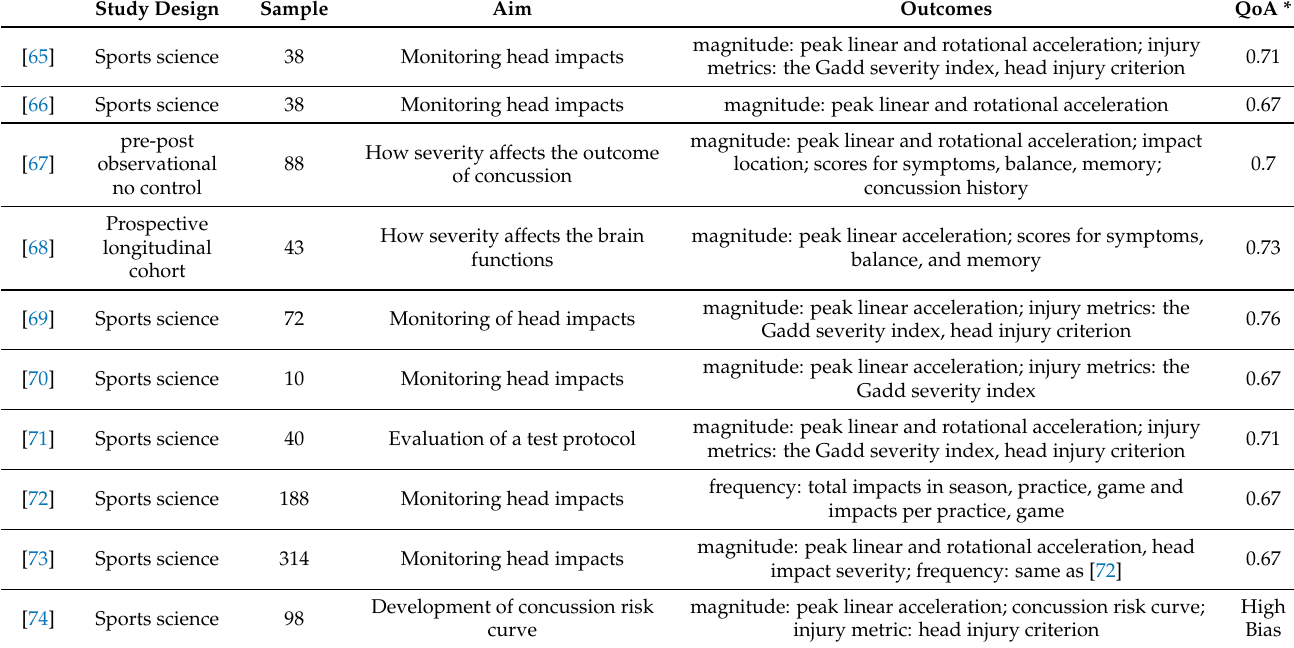
Table 2. Studies regarding the biomechanics of concussions studied by